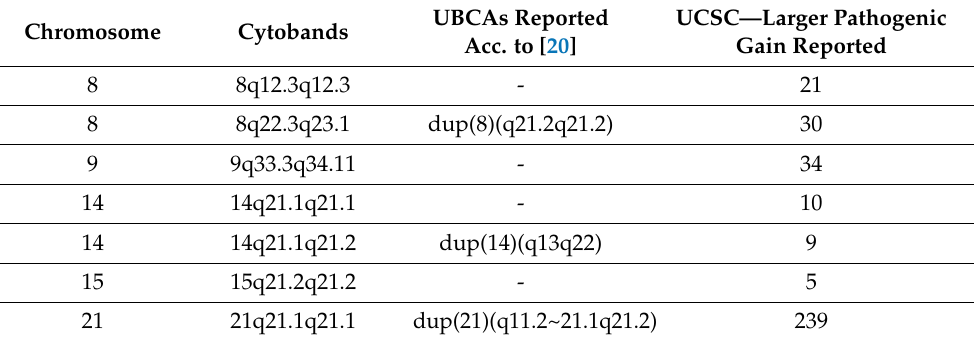
Table 4. Comparison of regions present as partial trisomy due to the sSMC in the present patient, UBCA cases [20], and number of pathological cases listed in UCSC in case the corresponding region was duplicated. Chromosome Cytobands